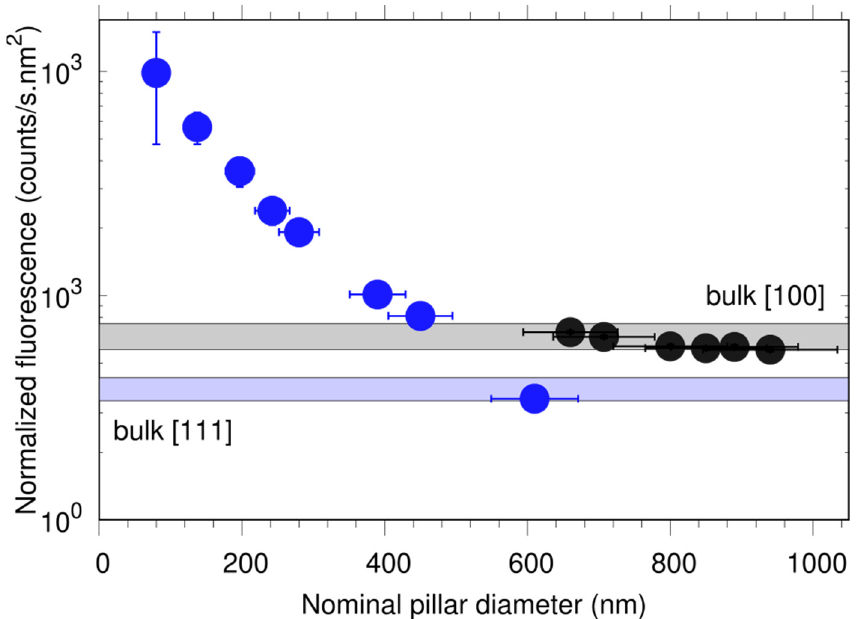
Figure 5 . Fluorescence signal from the pillars as a function of the nominal pillar diameter in the [111] (blue) and [100] (black) samples. The measured photon count rate was kept below 10 MCounts/s using a neutral density filter in order not to saturate the APD. The light blue and grey rectangles show the estimated number of NVs in the bulk structures. See text for details.